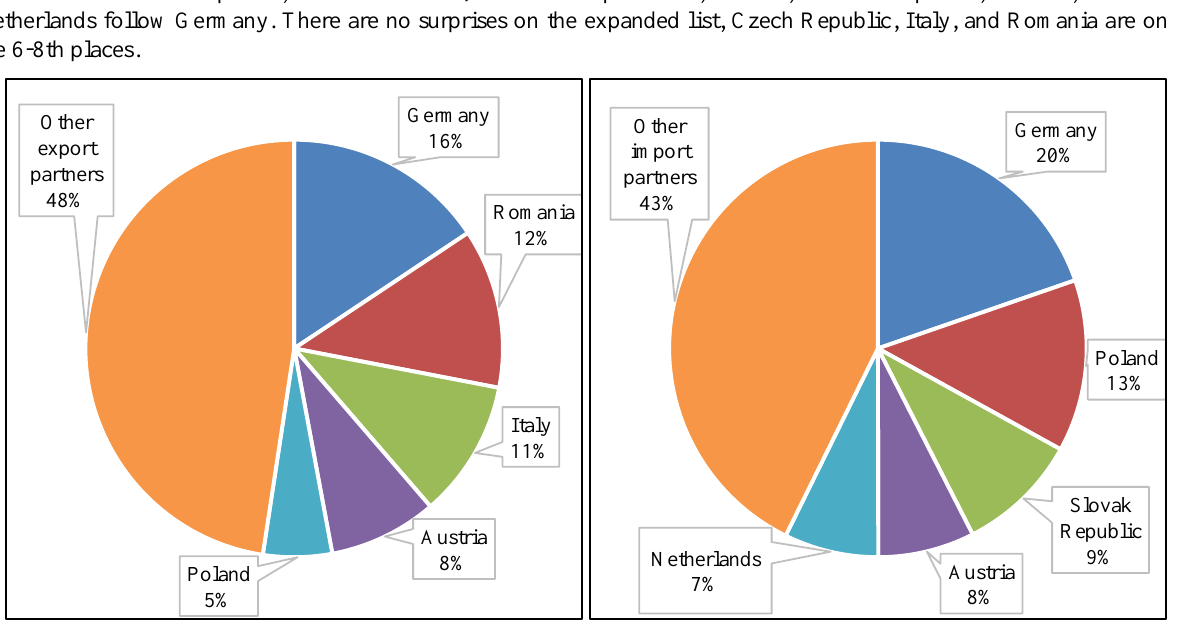
Figure 7. The major Hungarian agri-food import and export partners, 2019; Source: Author’s composition based